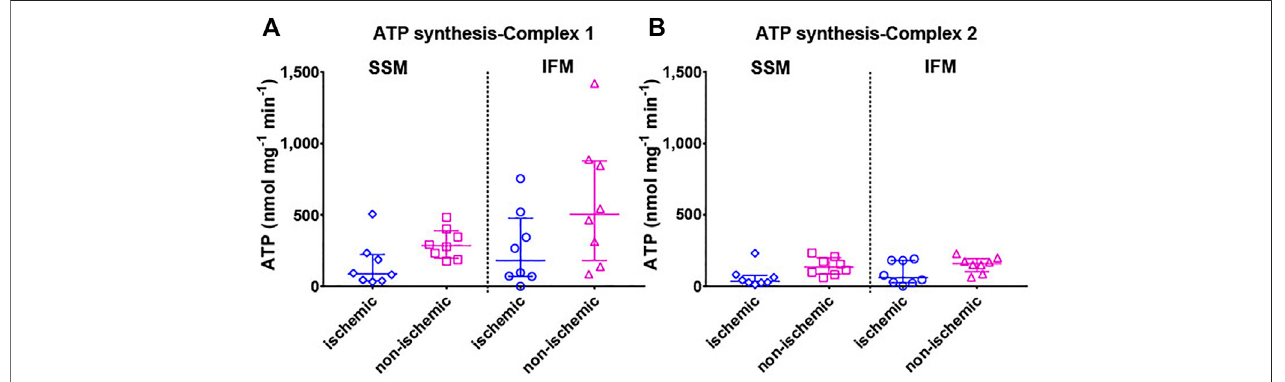
FIGURE5| MitochondrialATPproduction rateisshownwith (A) mitochondrialcomplexI(pyruvate +malate) and (B) complexII(succinate +rotenone)substrates. Values are represented as median with interquartile range ( n = 7 – 8/group). For exact p -values of all group comparisons, please refer to Table 2 .